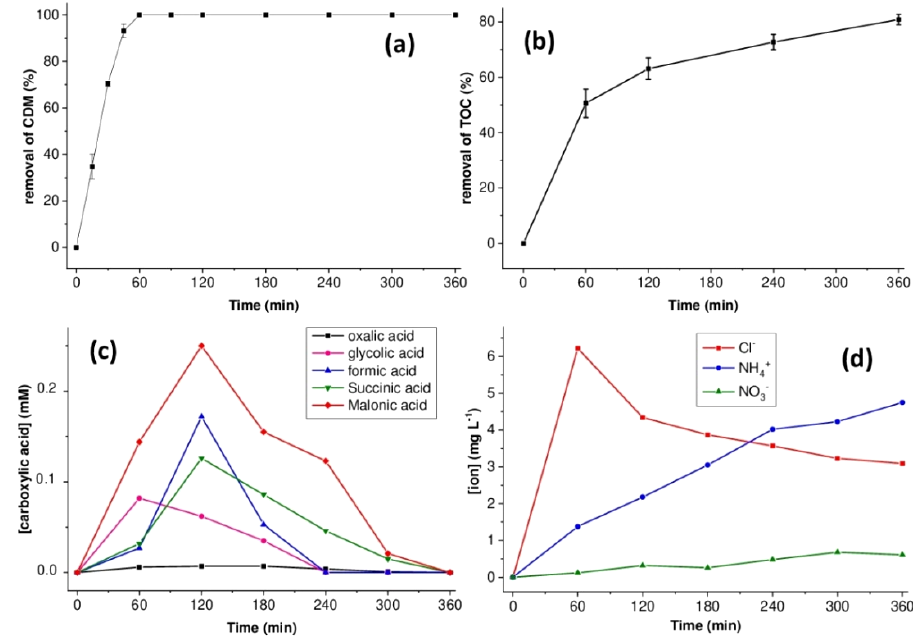
Figure 3. Treatment of a real effluent: ( a ) % removal of CDM; ( b ) % removal of TOC; ( c ) [carboxylic acids] vs. time ( d ) [ions] vs. time: I = 70 mA in the presence of 1 g L − 1 of TiO 2 /Fe 3 O 4 -CS(2) and at pH initial = 3.